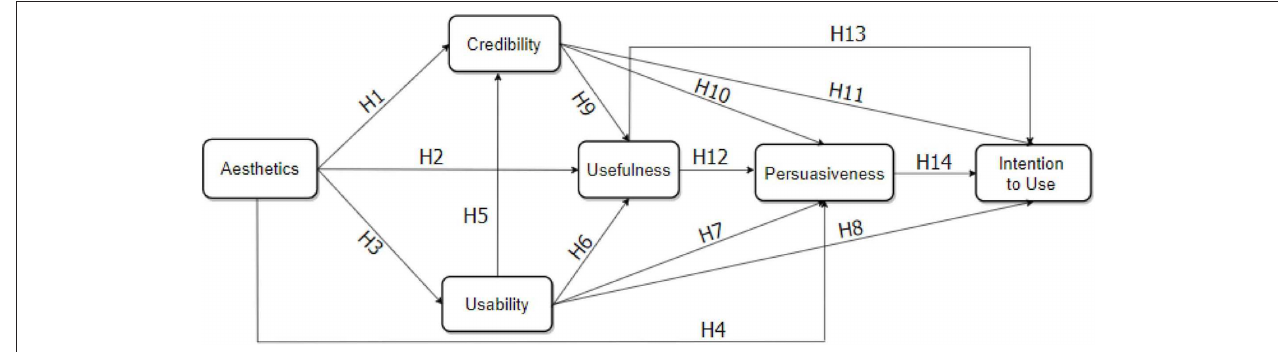
FIGURE 2 | Hypothesized model of persuasive technology